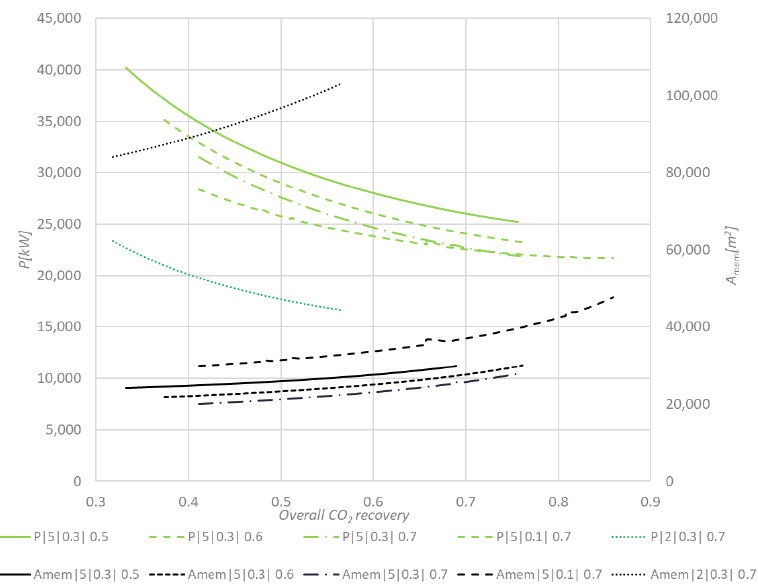
Figure 6. Sensitivity study: Compression power (P) and membrane surface area (A mem ) as a function of the overall CO 2 recovery. Legend format: p feed | p permeate | CO 2 recovery in the second-membrane stage. CO 2 recovery in the first stage is fixed at 0.7 .